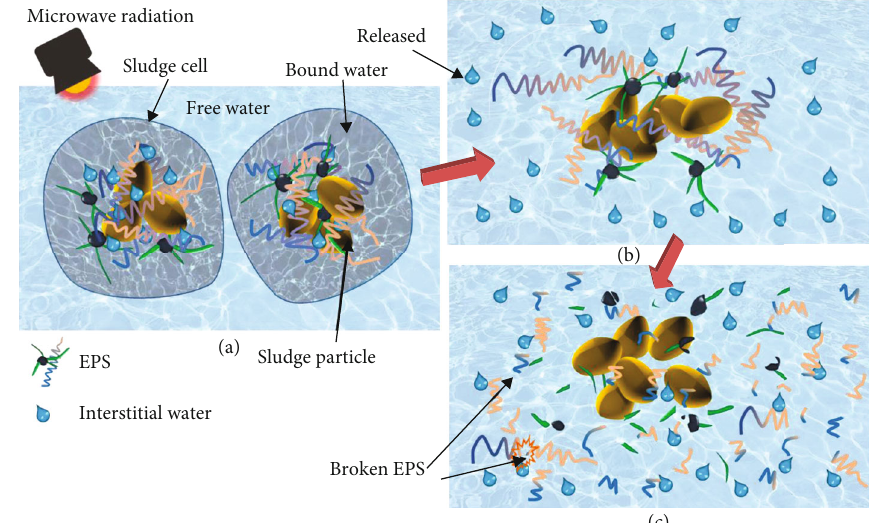
Figure 4: Mechanism diagram of sludge disintegration by microwave